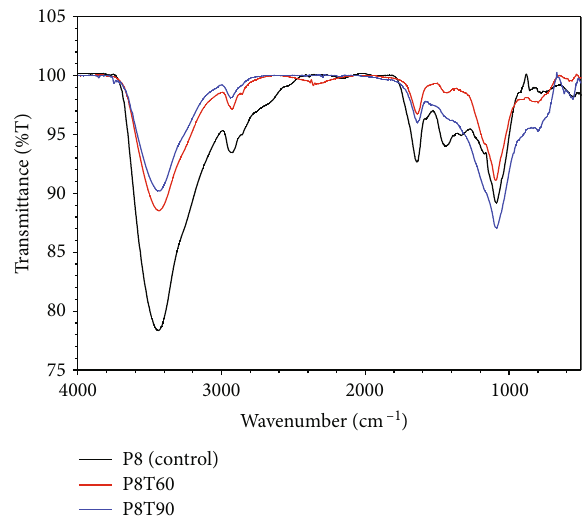
Figure 3: FTIR spectra of P8, P8T60, and